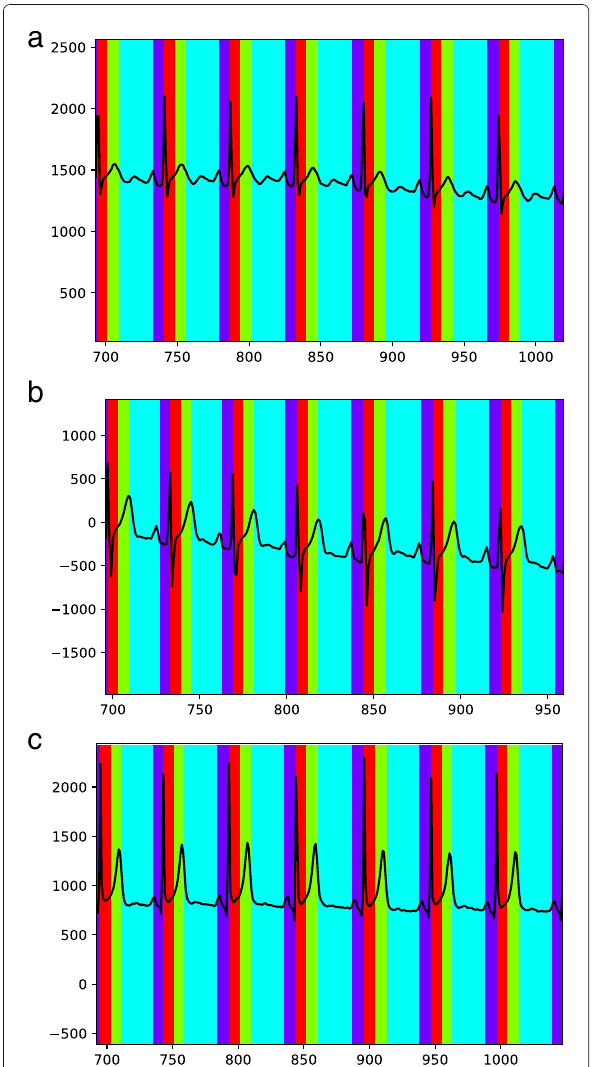
Fig. 3 Classifier applied to patients from category ‘healthy control’ for the individual categories vary a lot (e.g. there are 148 subjects for myocardial infarction whereas the entire cate-